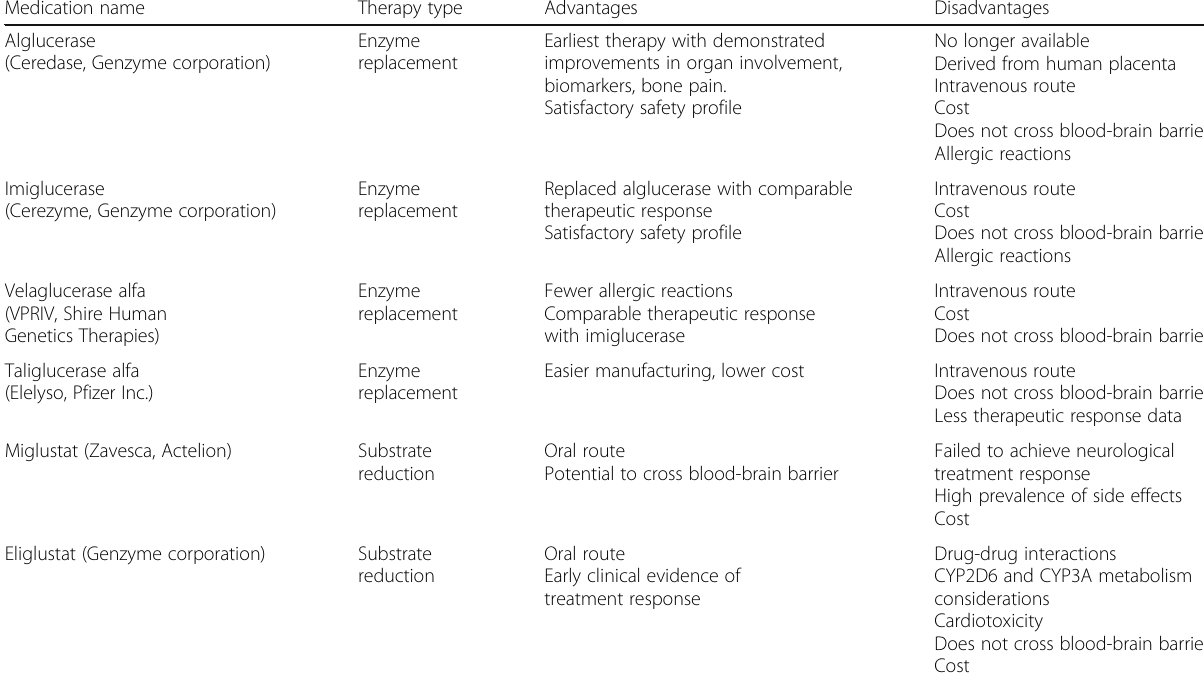
Table 3 Historic and available therapies for Gaucher